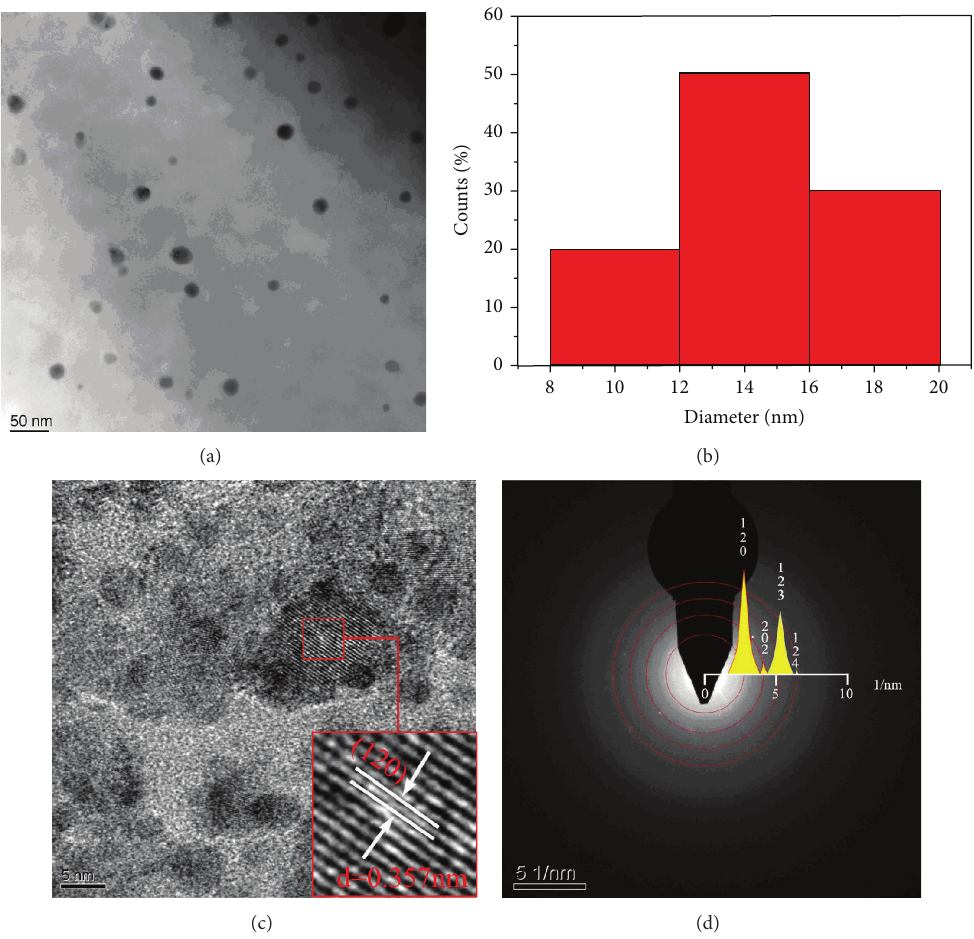
Figure 4: TEM analysis of the as-obtained glass: (a) morphology image; (b) size distribution; (c) HRTEM image; (d) SAED image.